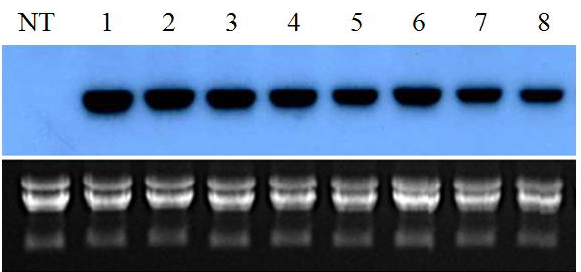
Figure 3. Northern blot analysis of the MsHsp23 gene in control and transgenic tall fescue plants. Total RNA (10  g) was separated by electrophoresis on an agarose gel, blotted on a nylon membrane, and hybridized with 32 P-labeled MsHsp23 specific cDNA